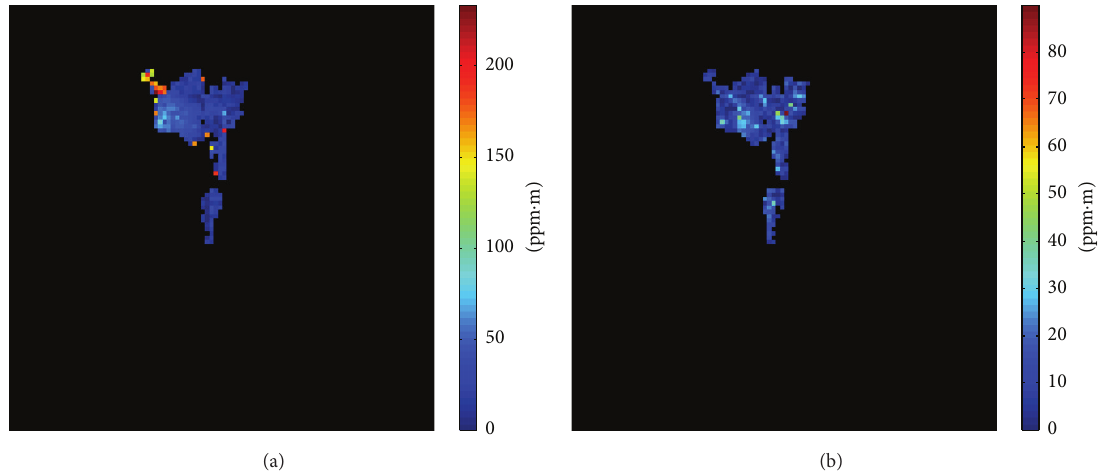
Figure 20: Comparison between retrieved concentration from the different approaches. (a) Difference between retrieved concentration from SB background estimation and CSB background estimation. (b) Difference between retrieved concentration from CB background estimation and CSB background